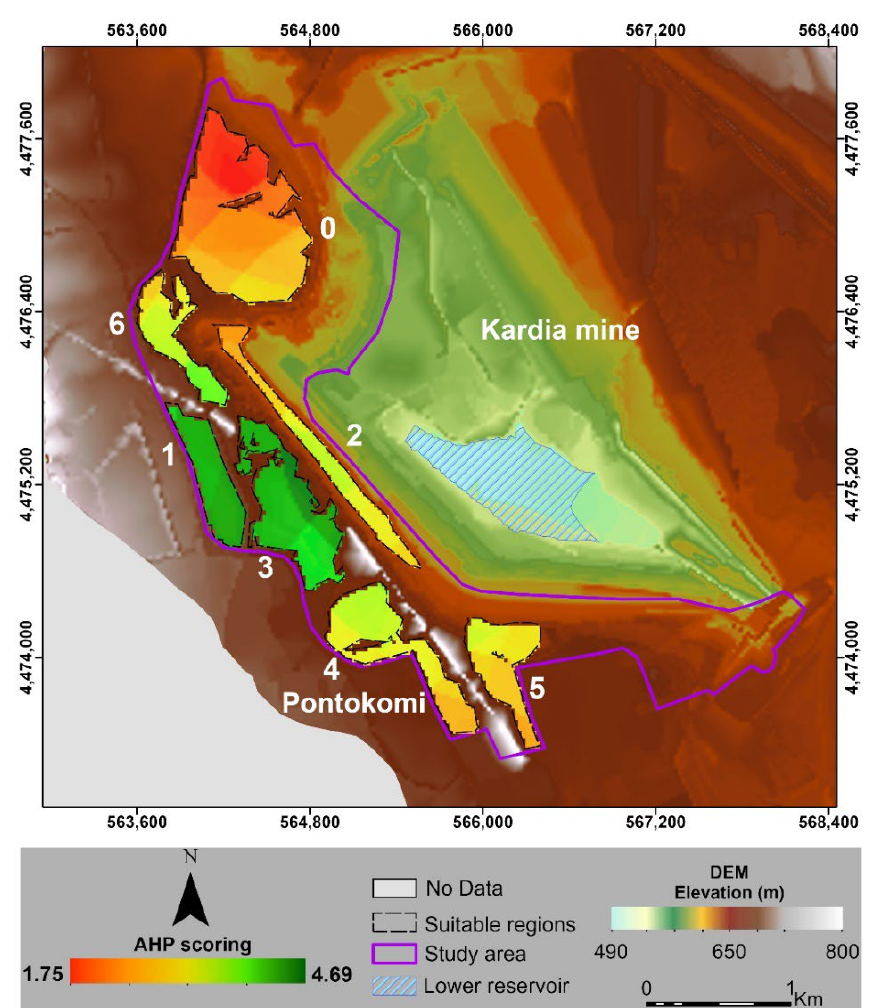
Figure 11. Ranking suitability map for the construction of upper reservoir using AHP method. The green color illustrates the areas with the higher suitability score and red color the lower, respec- tively.